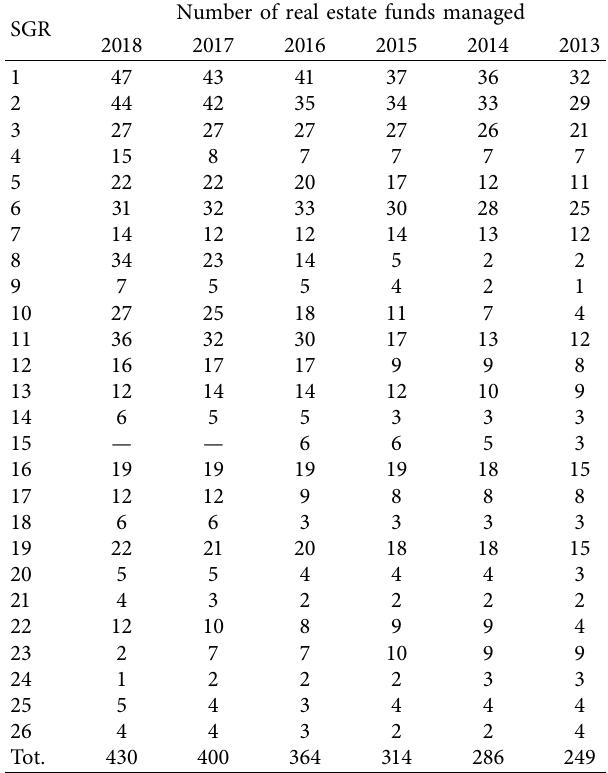
Table 4: Amount of asset under management for each SGR from Table 5: Number of real estate funds for each SGR from 2013 to 2018.